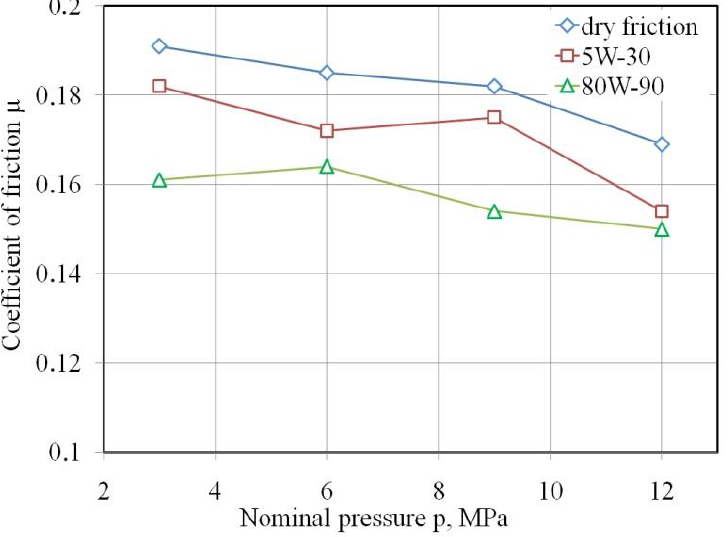
Figure 8. Effect of nominal pressure on the value of coefficient of friction.